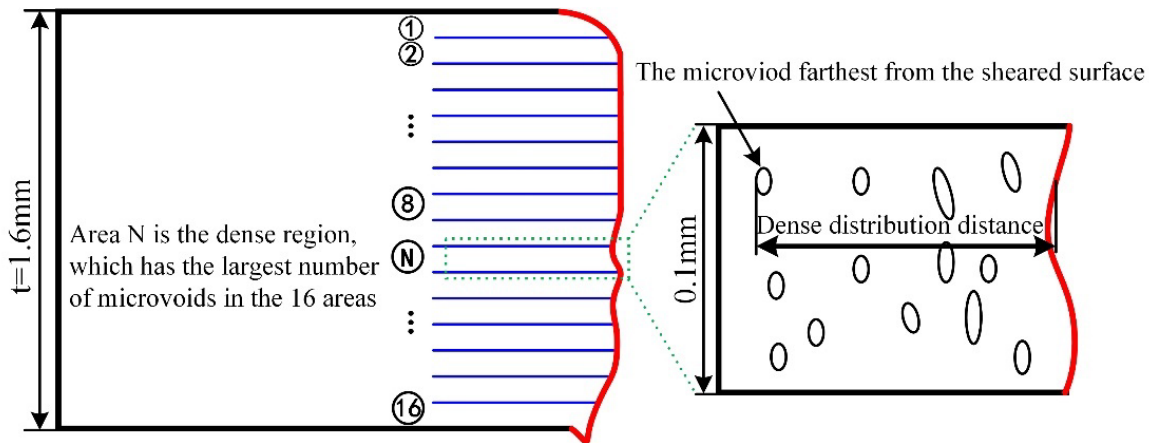
Figure 17. Method of determining the dense distribution distance.